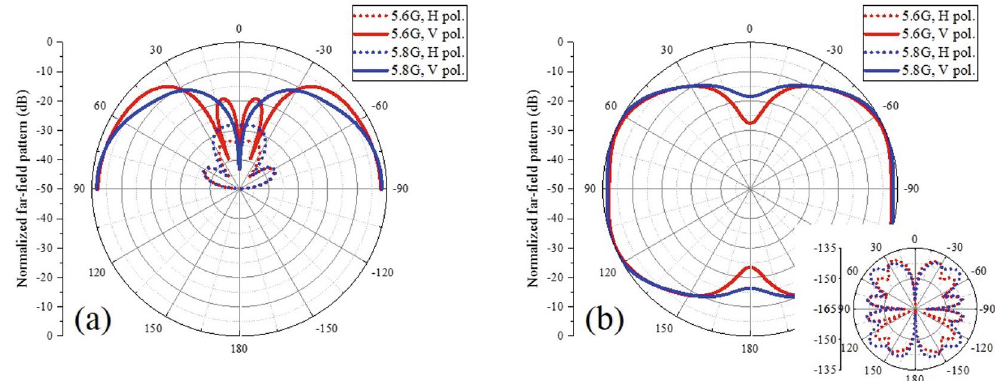
Figure 6. Simulated normalized patterns of the dual-mode bidirectional antenna with an infinite ground: ( a ) in the yz plane and ( b ) xy plane. For this antenna, the yz plane and xy plane are the E plane and H plane, respectively. The H pol. and V pol. in the figure represent the horizontally polarized component and vertically polarized component, respectively. The radiation at both 5.6 GHz and 5.8 GHz are bidirectional and the horizontally polarized component is much smaller than the vertically polarized